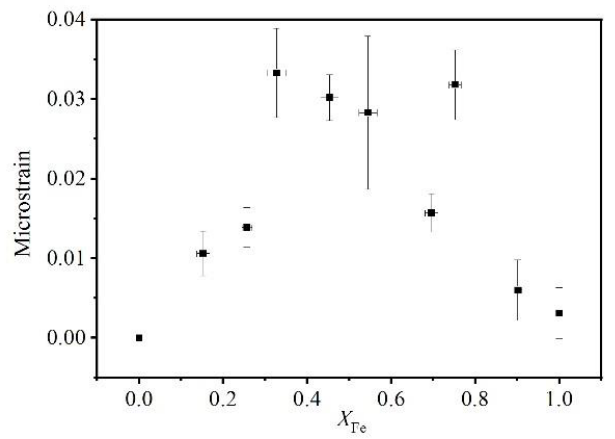
Figure 10. Microstrain inside garnet structure calculated from X-ray peak broadening along the pyrope–grossular join.